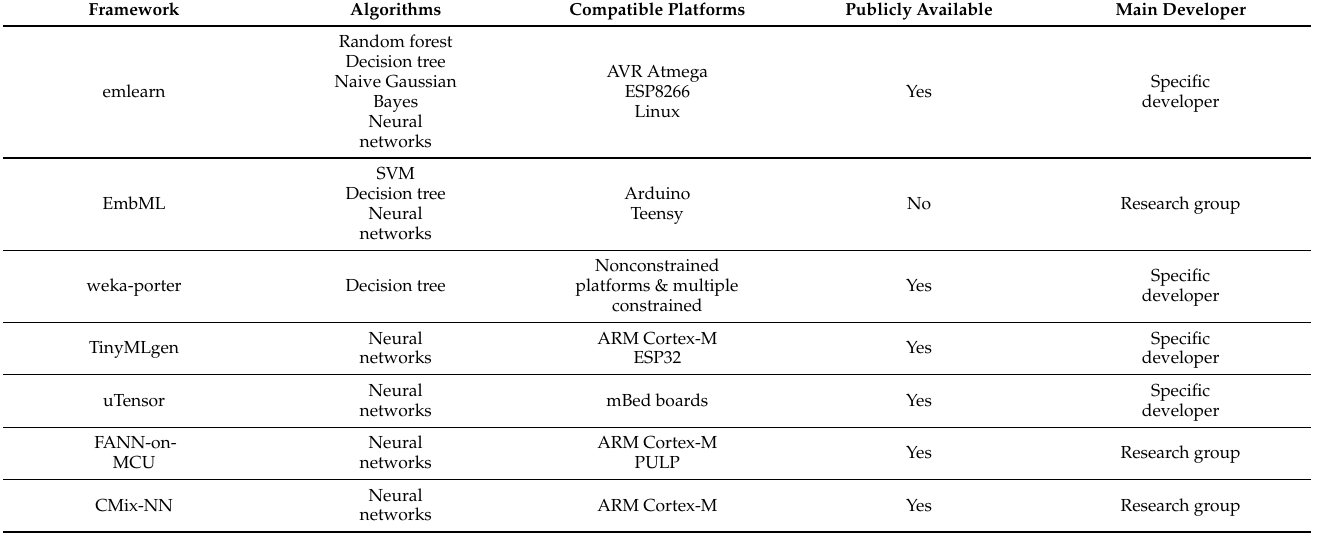
Table 4. TinyML Frameworks & Libraries.